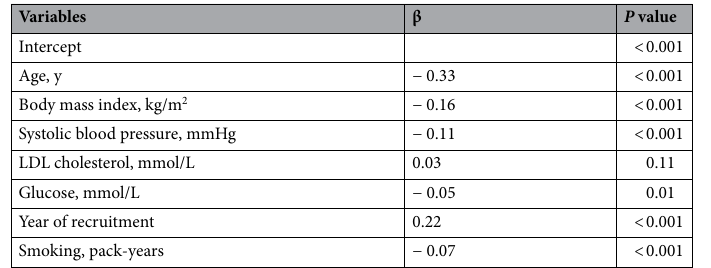
Variables β P value